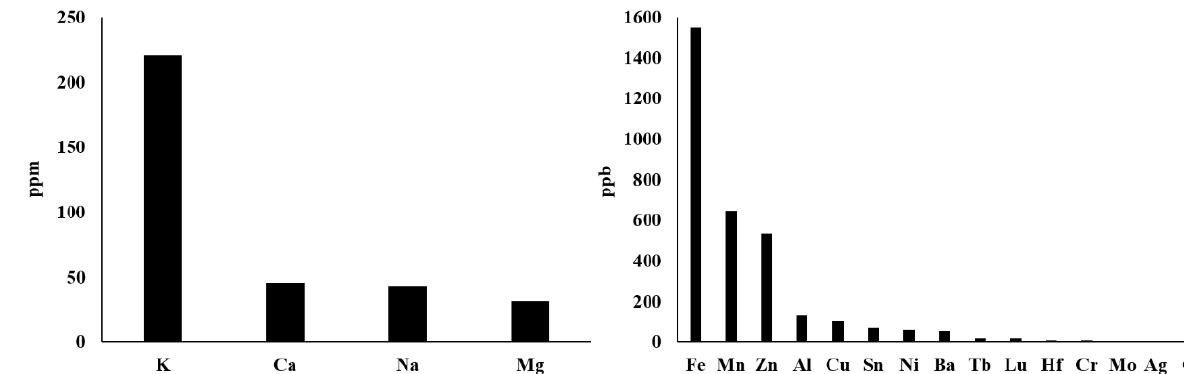
Figure 2. The contents of metal ions in mitochondria of HepG2 cells. The abundance decreases from left to right. HepG2 cells overexpressed the HA tag located on the MOM, and then mitochondria were quickly isolated using a HA-based magnetic bead (HA antibody-conjugated beads) system. After mitochondria were lysed, the abundance of metal ions was measured by ICP – MS.